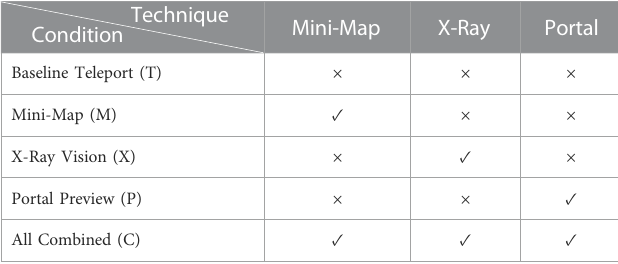
TABLE 1 Different conditions of the experiment and the corresponding availability of interaction